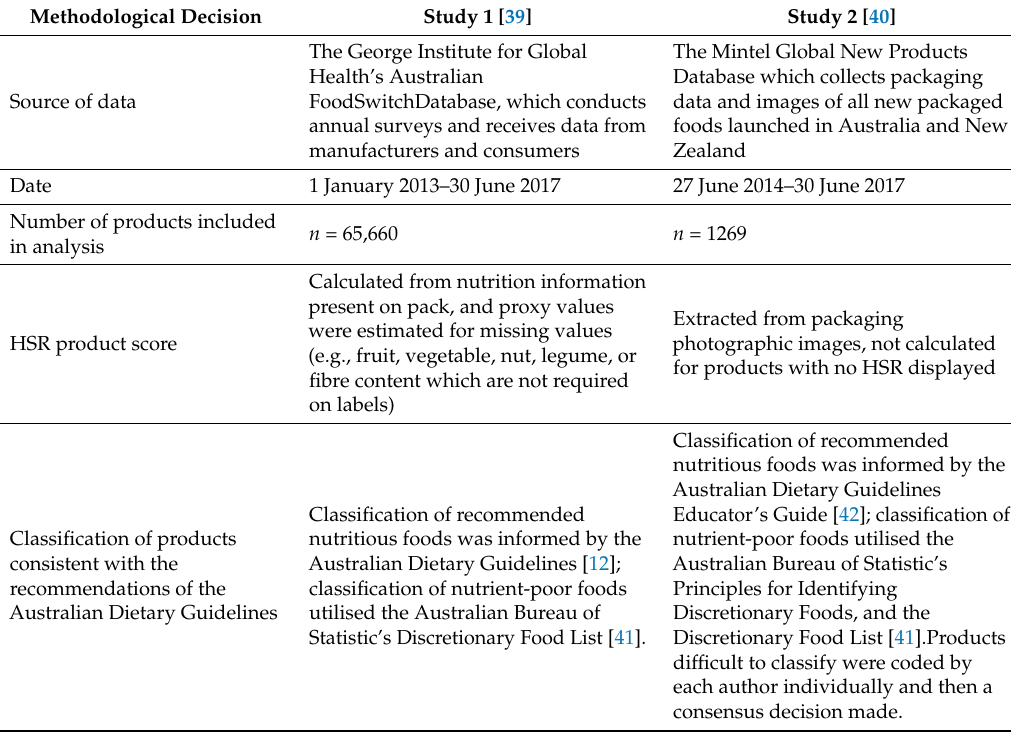
Table 1. Methodological decisions that can influence study findings on whether HSR product scores are consistent with recommendations of the Australian Dietary